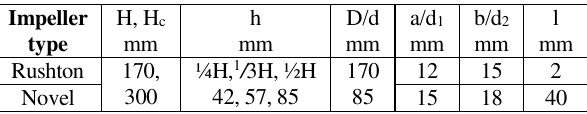
Table 1. Dimensions of the stirred